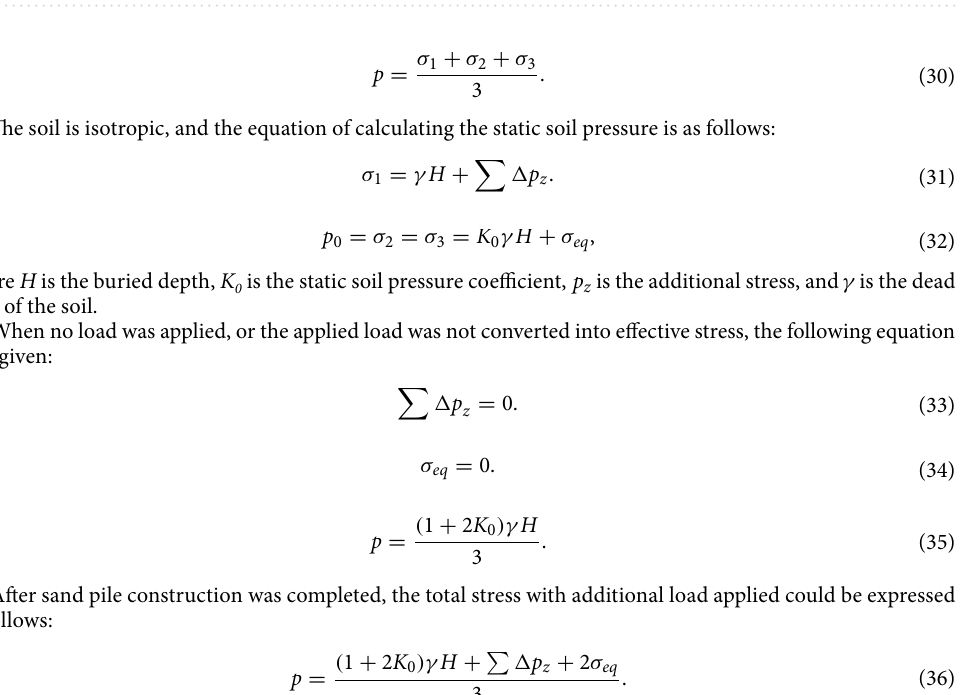
Figure 3. Curve of basic bearing capacity with natural water